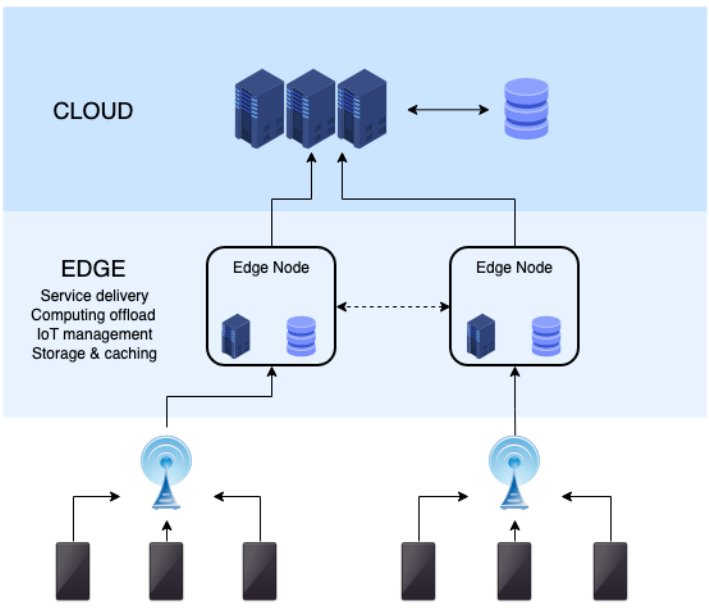
Figure 1. Abstract diagram representing the different layers in Edge Computing. Optimally, the higher layers deal with non-critical tasks that are compute intensive, which allows for a more resilient system. Source: